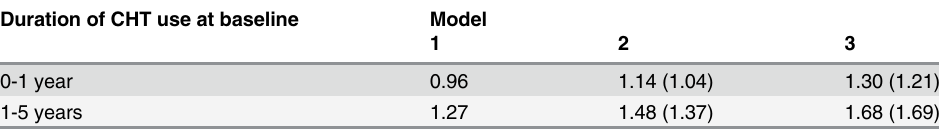
Model 1 is a regression model with 3 year follow-up (scenario 1); model 2 is the same model assuming that 10% starts using hormones every year in the non-user group (scenario 2); in model 3 (scenario 3) it is assumed that the incidence rates in the fi ctive study were identical to that observed for all 16 608 women of the WHI trial. In parenthesis we also give HR when assuming that 5% start using hormones every year in the non-user